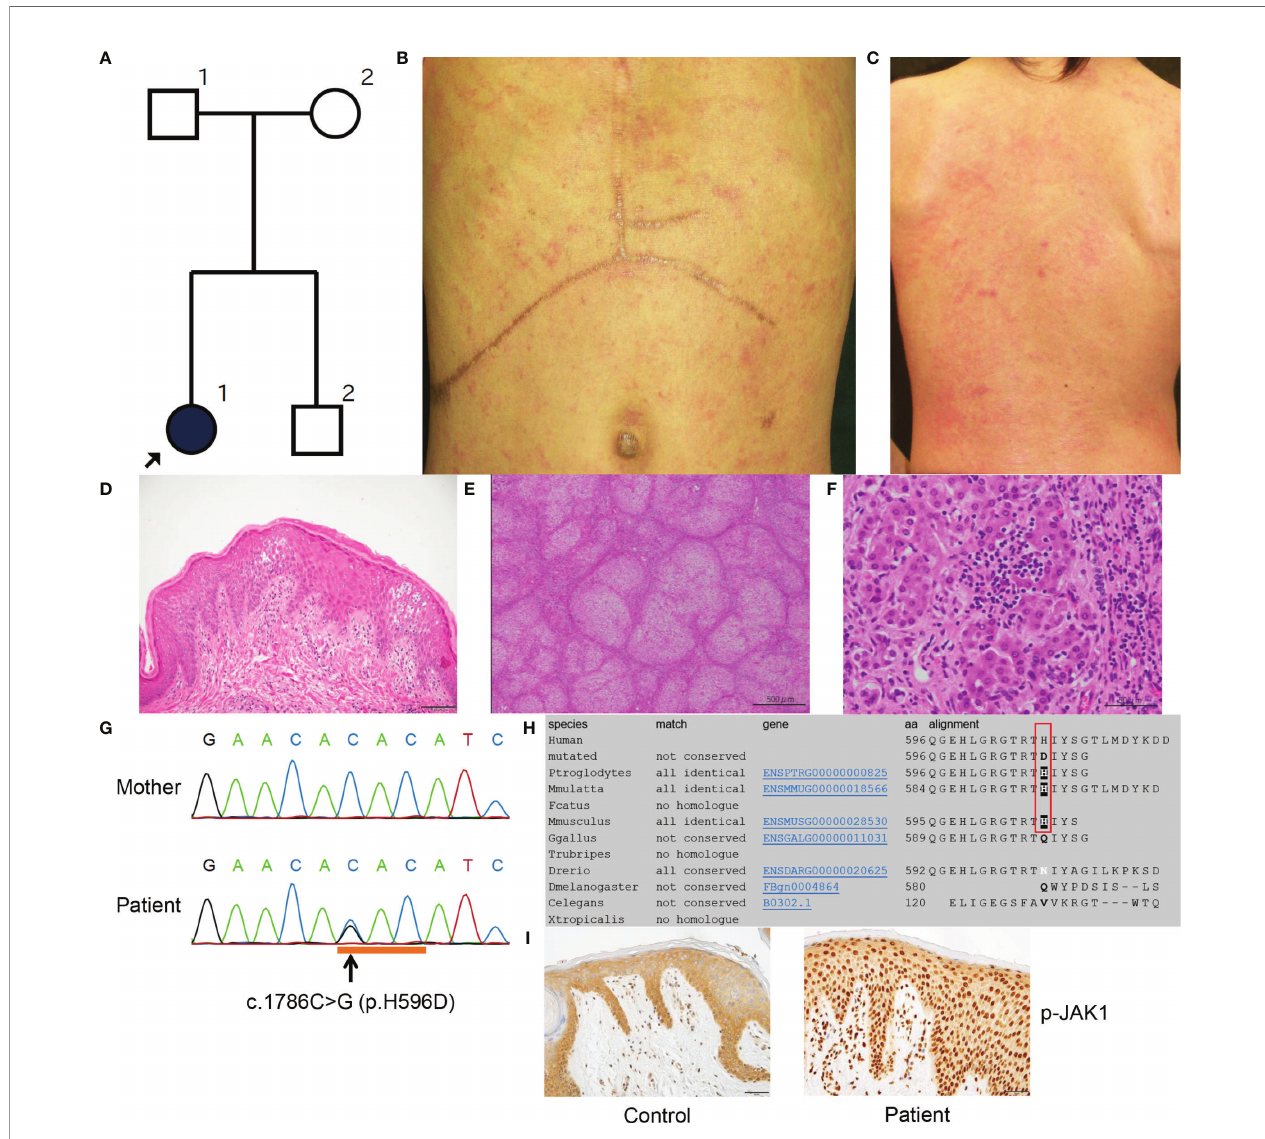
FIGURE 1 | Clinicopathologic features of the present patient with a JAK1 mutation. (A) Family tree of the present pedigree. (B, C) Scratched erythema and small red papules are seen on the trunk (B) and the back (C) . (D) A biopsy sample from erythematous skin of the proband shows compact hyperkeratosis, moderate acanthosis, mild spongiosis and lymphocytic in fi ltration within the epidermis and the upper dermis. Scale bar = 100 µm. (E) Histologically, the structure of the liver parenchyma has been remodelled into a nodule by fi brosis, resulting in cirrhosis. Scale bar = 500 µm. (F) In fl ammatory cell in fi ltration mainly composed of small lymphocytes (a few plasma cells) is observed in the nodule, accompanied by a mild necrotic in fl ammatory reaction with hepatocyte shedding. Scale bar = 50 µm. (G) Sanger sequencing reveals the heterozygous missense mutation c.1786C>G (H596D) in JAK1 . (H) JAK1 amino-acid sequence alignment shows the level of conservation in diverse species of the amino-acid p.H596 (red box), which was altered by the missense mutation in the present patient. (I) The epidermis in an affected lesion from the patient and normal skin from a healthy donor were stained with anti-p-JAK1 antibody. Scale bars = 50 µm. MutationTaster (http://www.